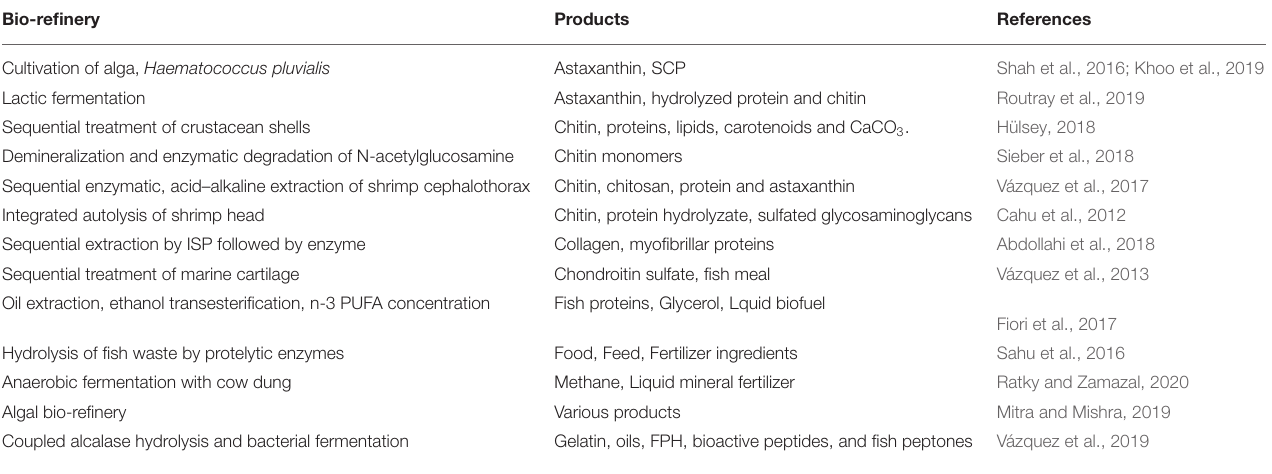
TABLE 6 | Bio-refinery approaches for valorization of seafood